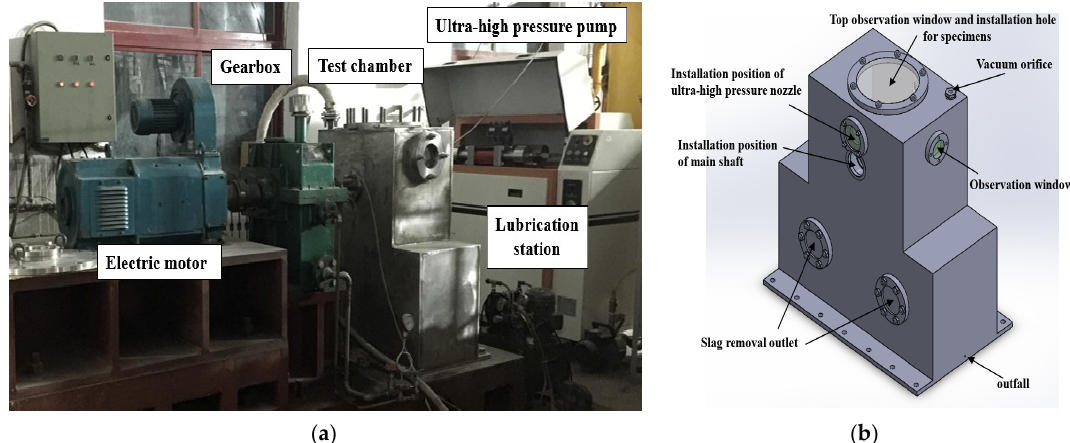
Figure 1. The high ‐ speed waterjet test system. ( a ) Real image of waterjet test system; ( b ). Schematic diagram of the test chamber.